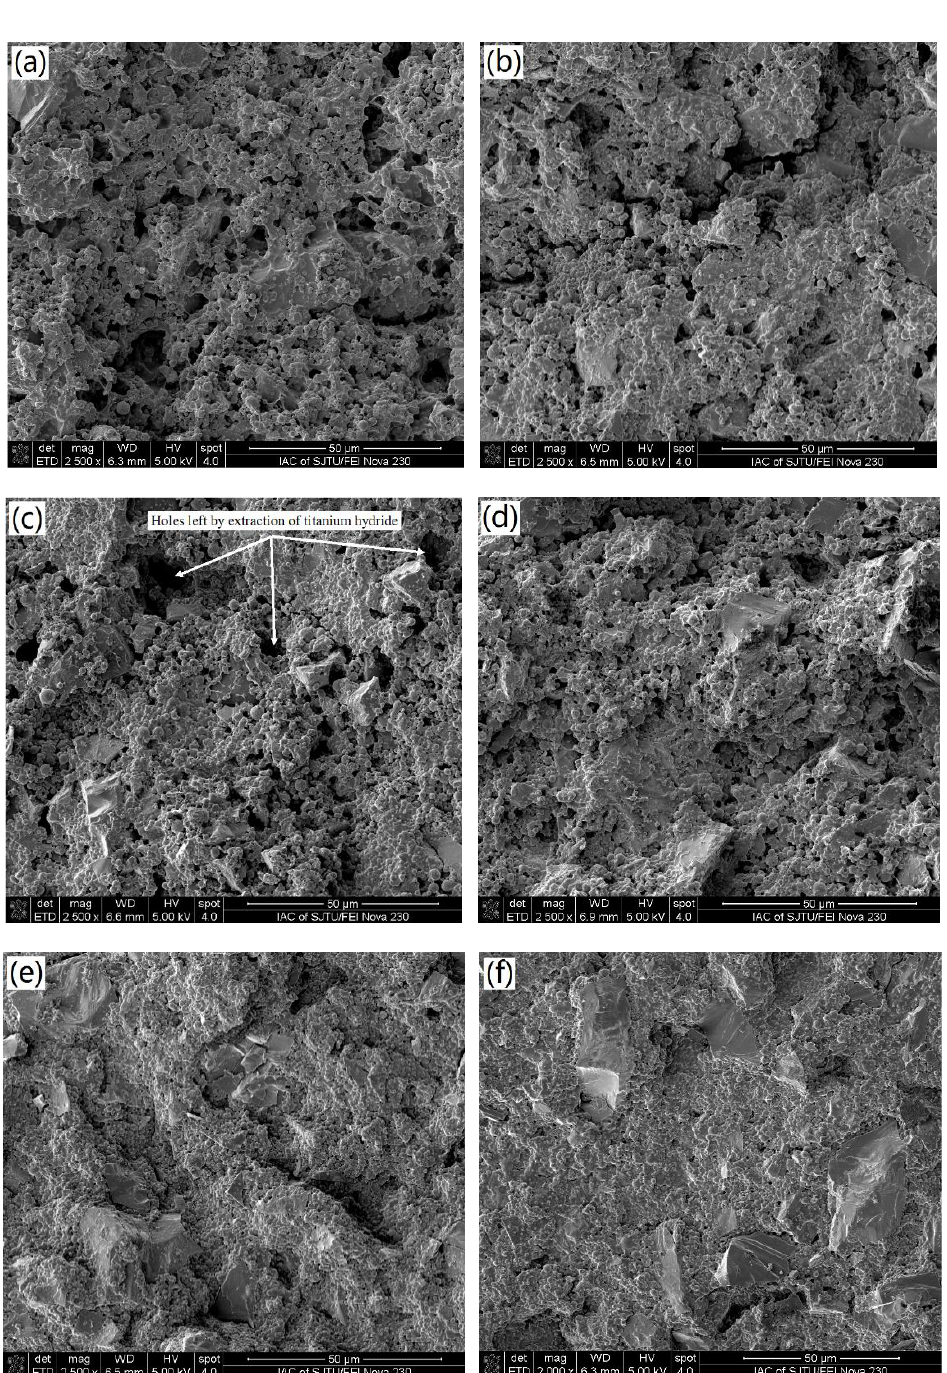
Figure 6. Cross-sectional micrographs of TiH 2 /Al green bodies gel casted from slurries with different monomer contents. ( a ) 15 vol %, ( b ) 20 vol %, ( c ) 25 vol %, ( d ) 30 vol %, ( e ) 35 vol %, and ( f ) 40 vol %.